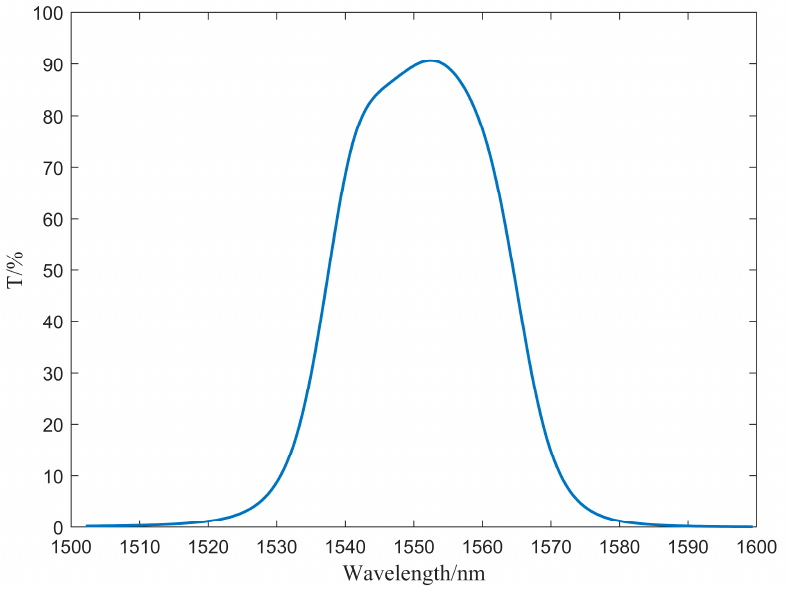
Figure 7. Transmission spectrum of the fi lter.